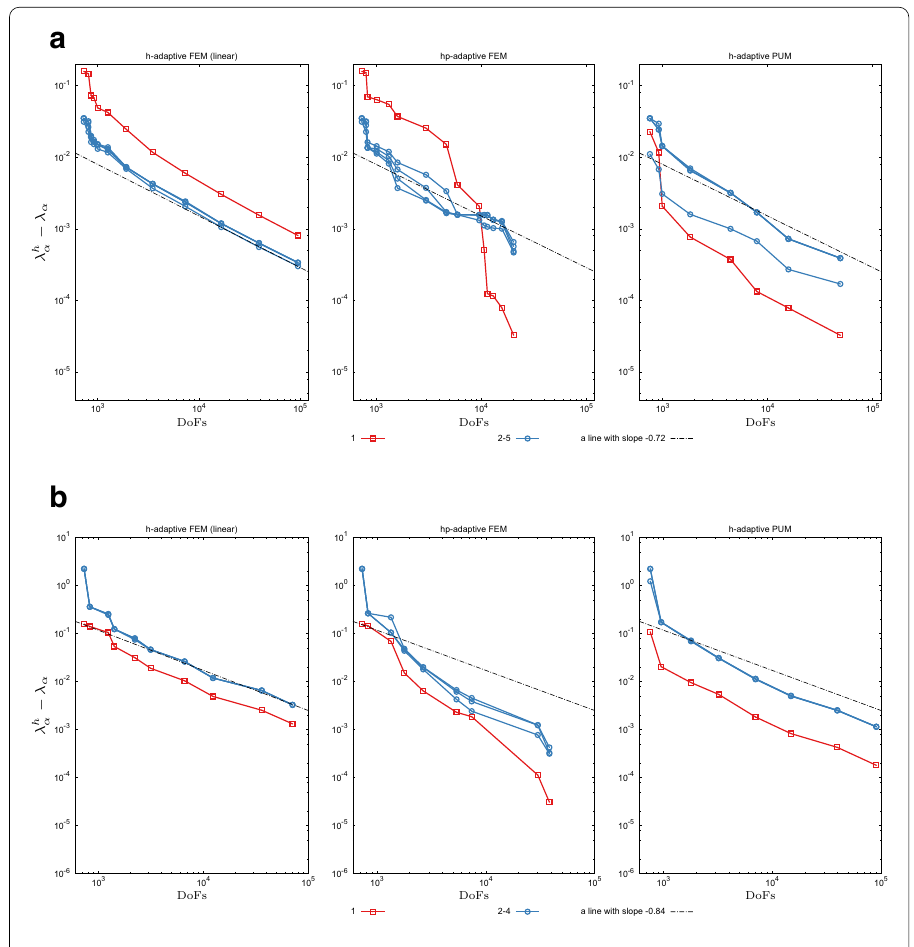
Fig. 4 Convergence of eigenvalues from the first two energy levels for the Schrödinger equation in the course of adaptive refinement. Red lines denote the lowest eigenvalue, whereas blue lines correspond to degenerate eigenvalues on the next energy level. a Coulomb potential (4 out of 5 eigenvalues are degenerate). b Harmonic potential (3 out of 4 eigenvalues are degenerate)